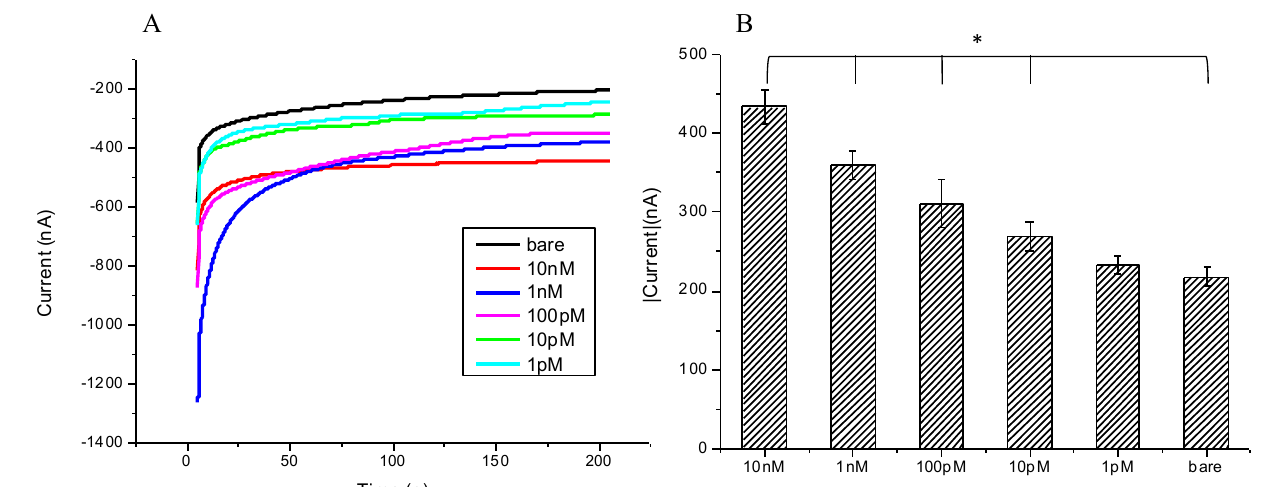
Figure 5. ( A ) Chronoamperometric diagram showing different concentrations of mimic SARS-CoV-2 target sequence were detected by the modified SPCE; ( B ) chronoamperometry to detect terminal current value, the currents decreased with the lower of concentrations of SARS-CoV-2 target sequence, the significant lowest concentration was 10 pM with p -value 0.0257. The bar chart also shows the triple examinations with confidence intervals. * meant p value < 0.005.